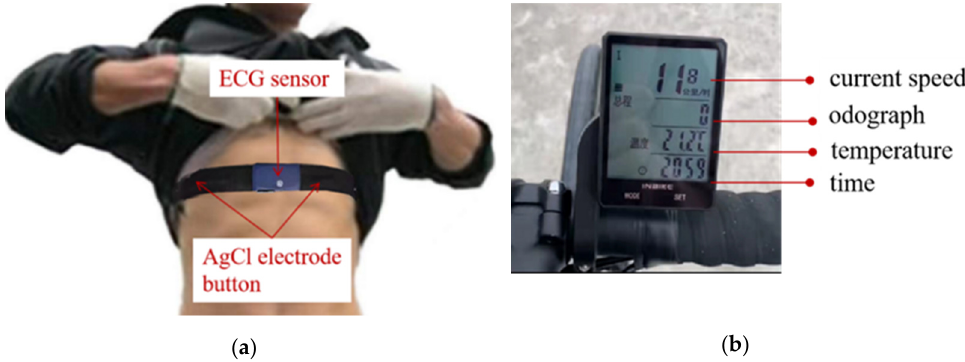
Figure 6. Main apparatus used in the field experiment. ( a ) BodyMon KF-2; ( b ) speedometer.